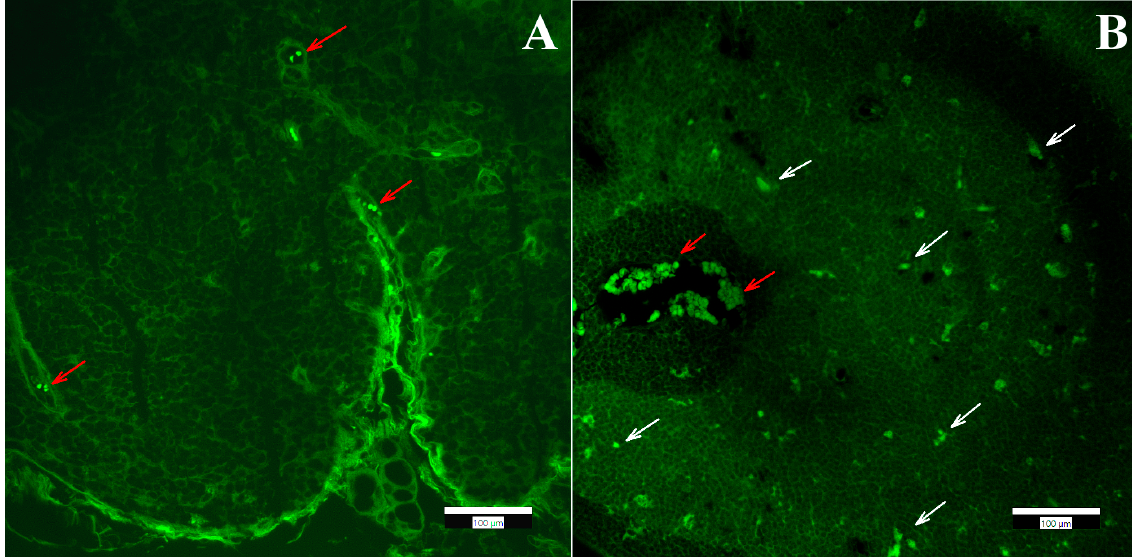
Figure 6. Panel ( A ): Autofluorescence of red blood cells (red arrows) inside control thymus tissue. Panel ( B ): Fluorescence of FSGM (white arrows) in “high dose”-treated thymus tissue. Scale bars: 100 µm.